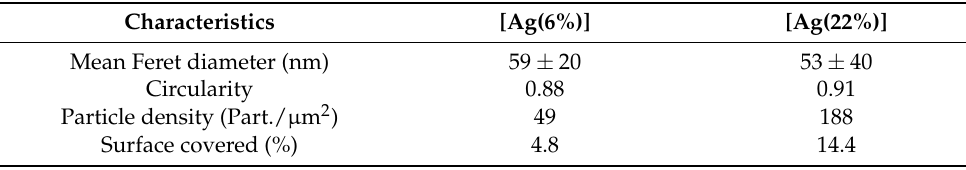
Table 1. Particle-size distribution characteristics of the as deposited